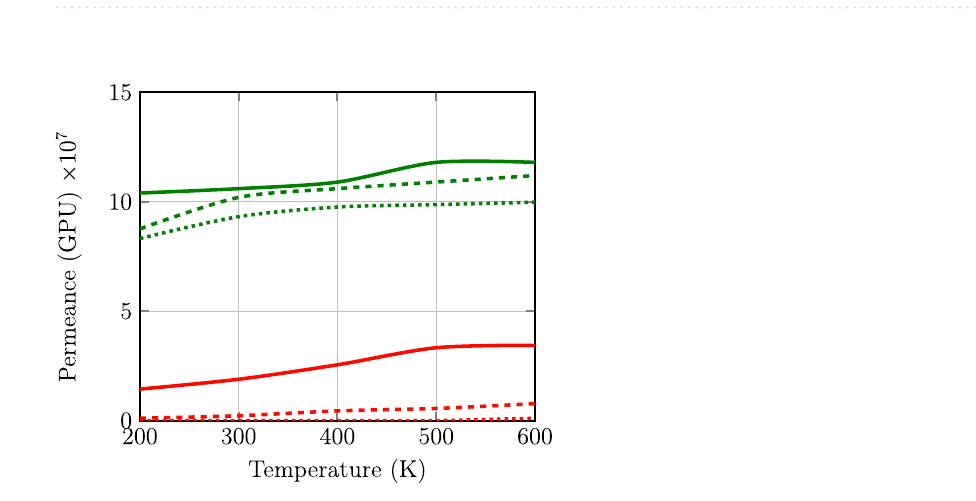
Table 3. Selectivity of H 2 over CO 2 molecules which passing through the GDY-H membrane at the range of 200–600 K.